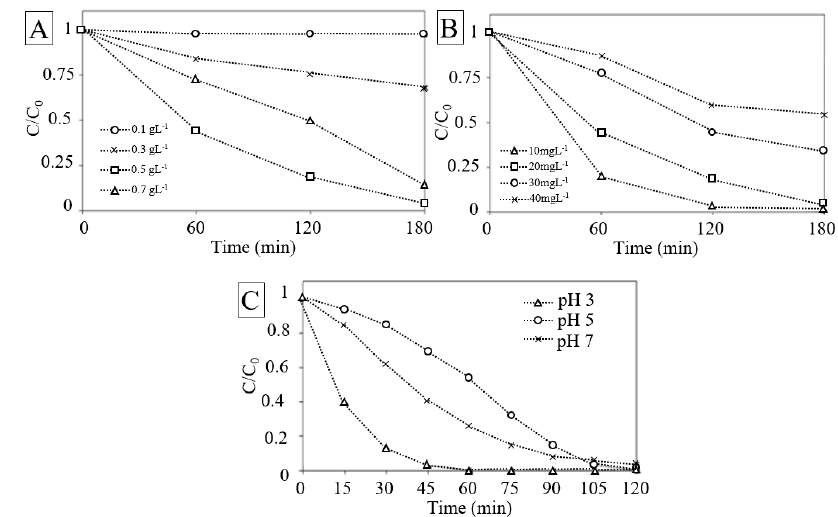
Figure 6. ( A ) Effect of catalyst load. ( B ) Effect of RhB initial concentration. ( C ) Effect of RhB initial pH value . Figure 6. ( A ) E ff ect of catalyst load. ( B ) E ff ect of RhB initial concentration. ( C ) E ff ect of RhB initial pH value.